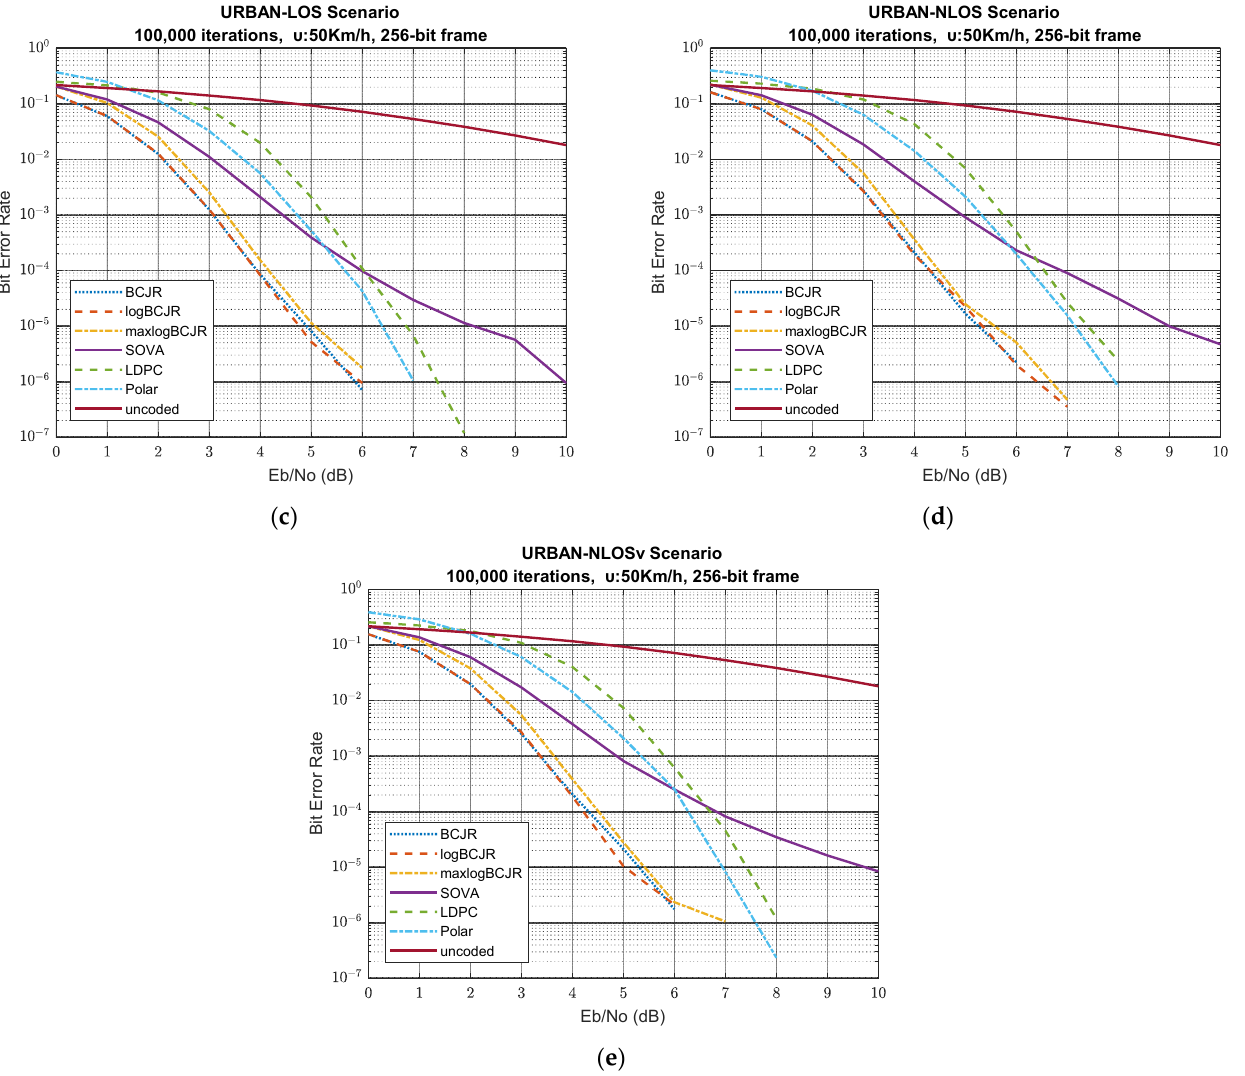
Figure 3. BER vs. SNR for scenarios 6 - 10 and 256-bit frame length. ( a ) highway - LOS scenario; ( b ) highway - NLOSv scenario; ( c ) urban - LOS scenario; ( d ) urban - NLOS scenario; ( e ) urban - NLOSv scenario. Table 9. SNR in dBs for BER values of 10 −3 and 10 −6 , 256-bit frame.